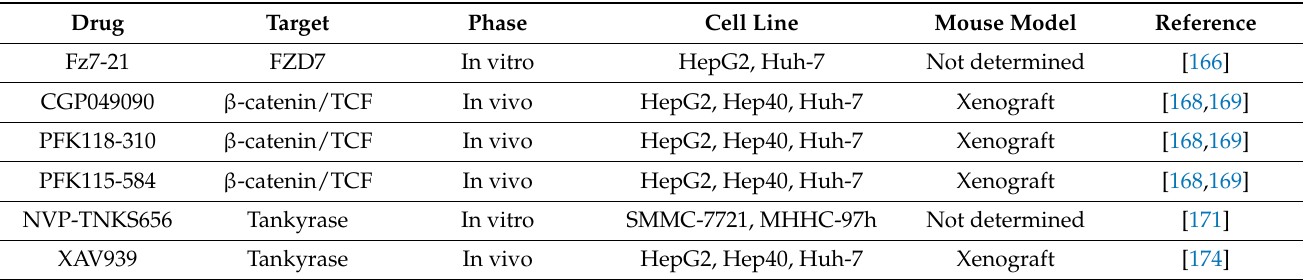
Table 3. Preclinical studies targeting Wnt/ β -catenin signaling in